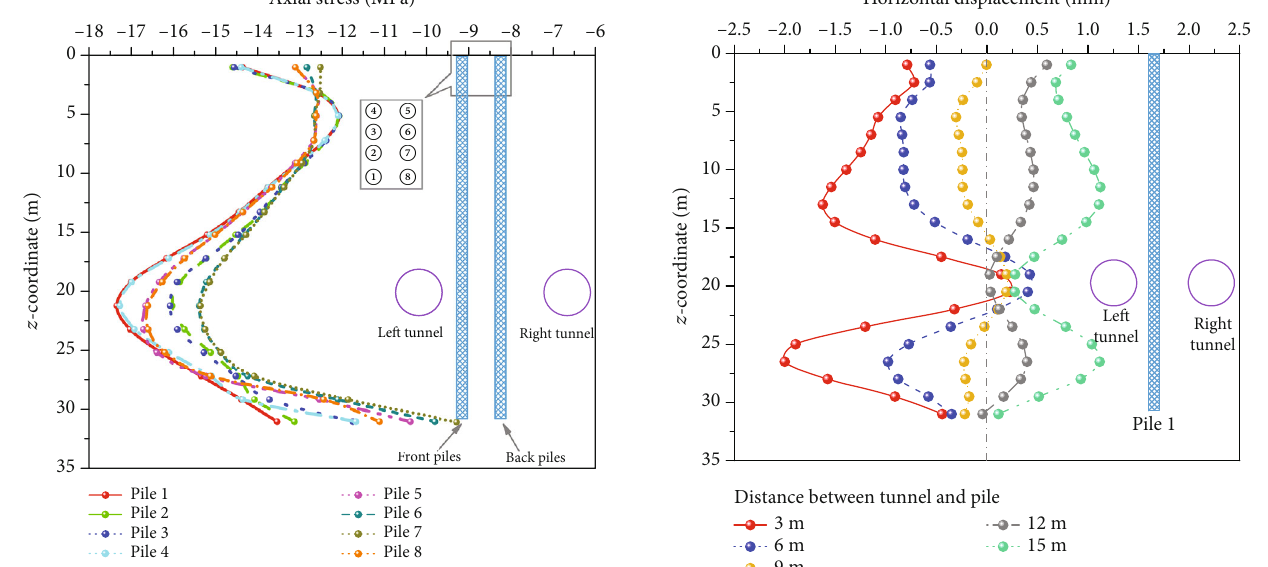
Figure 14: Horizontal displacements of Pile 1 on completion of twin tunneling at di ff erent pile-to-tunnel